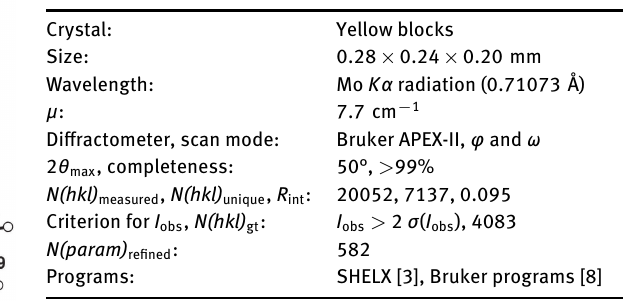
the title crystal structure is shown in the figure. Tables 1 and 2 contain details on crystal structure and measurement condi- tions and a list of the atoms including atomic coordinates and displacement parameters.